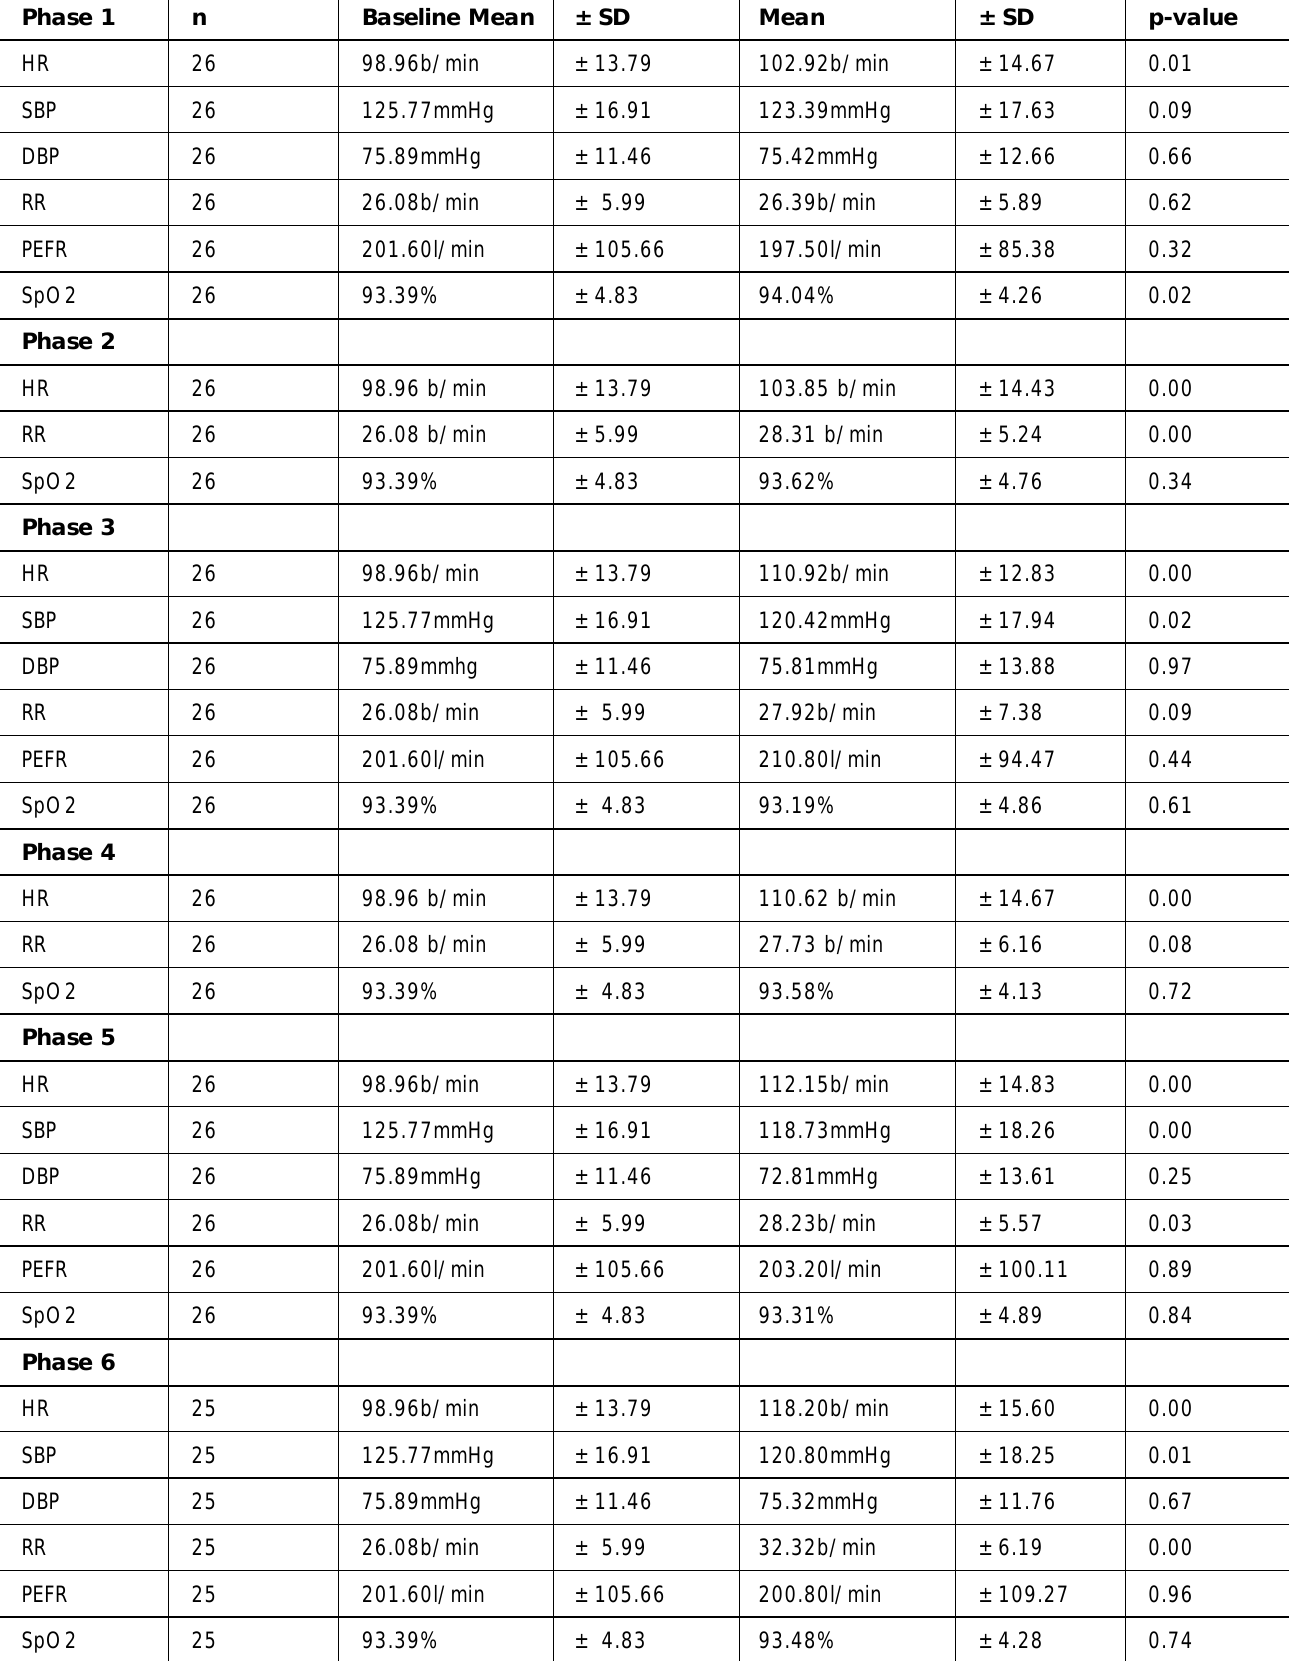
Table 5: Physiological response during the six-phase functional exercise